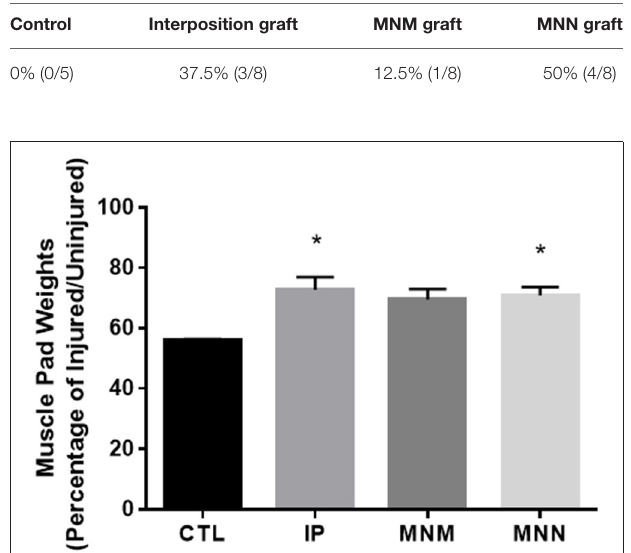
TABLE 1 | Percentage of animals per group achieving coordinated forward vibrissae movement (defined as a score of 5 or above) at 16 weeks.